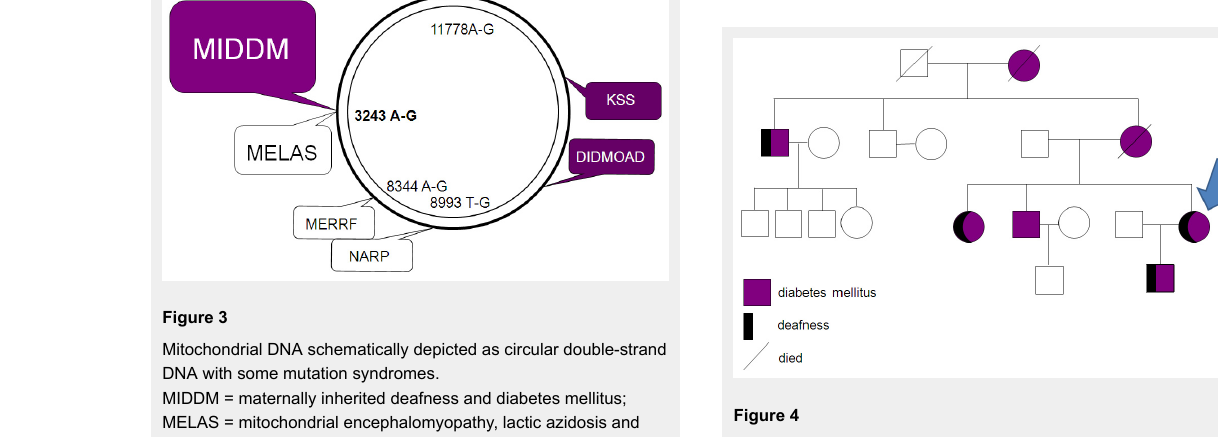
Pedigree of a 52-year-old woman with MIDDM (arrow), in whom diabetes was diagnosed at the age of 31 years during her first pregnancy with characteristic matrilinear transmission and hearing loss. In her son mitochondrial diabetes mellitus was diagnosed at the age of